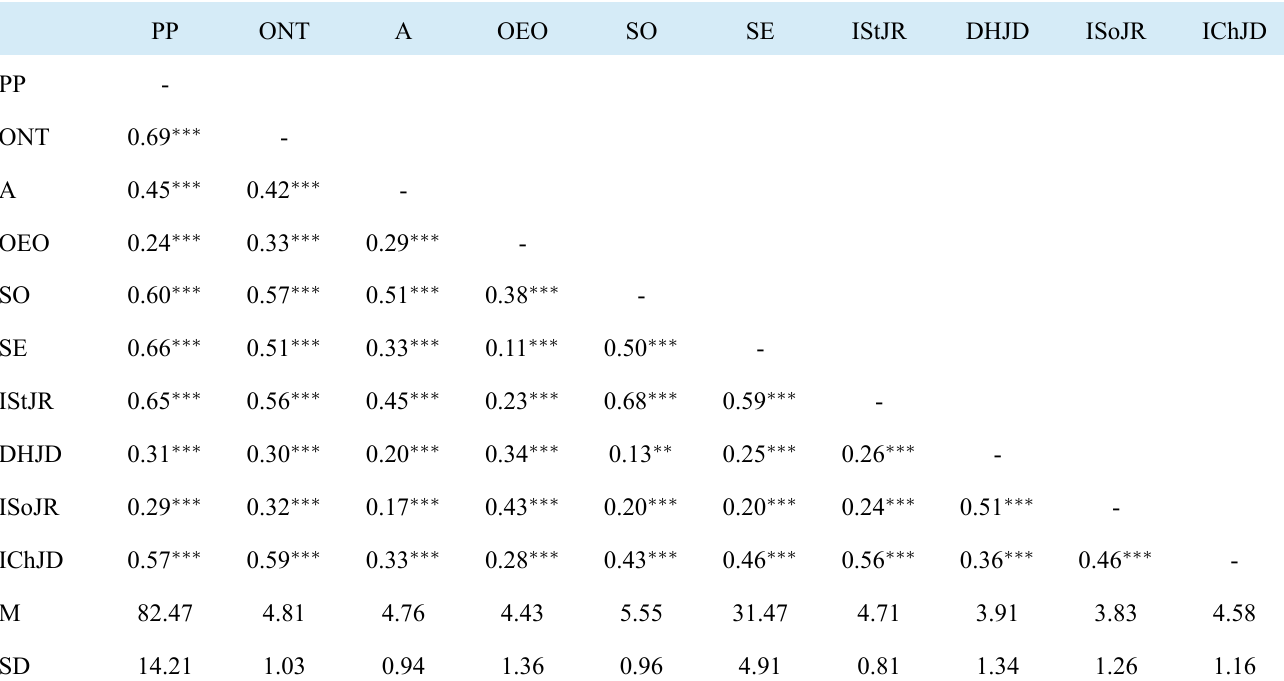
TABLE 1. Proactive personality, regulatory focus, Self-efficacy, and Job Crafting. Correlations and descriptive statistics. IStJR DHJD ISoJR